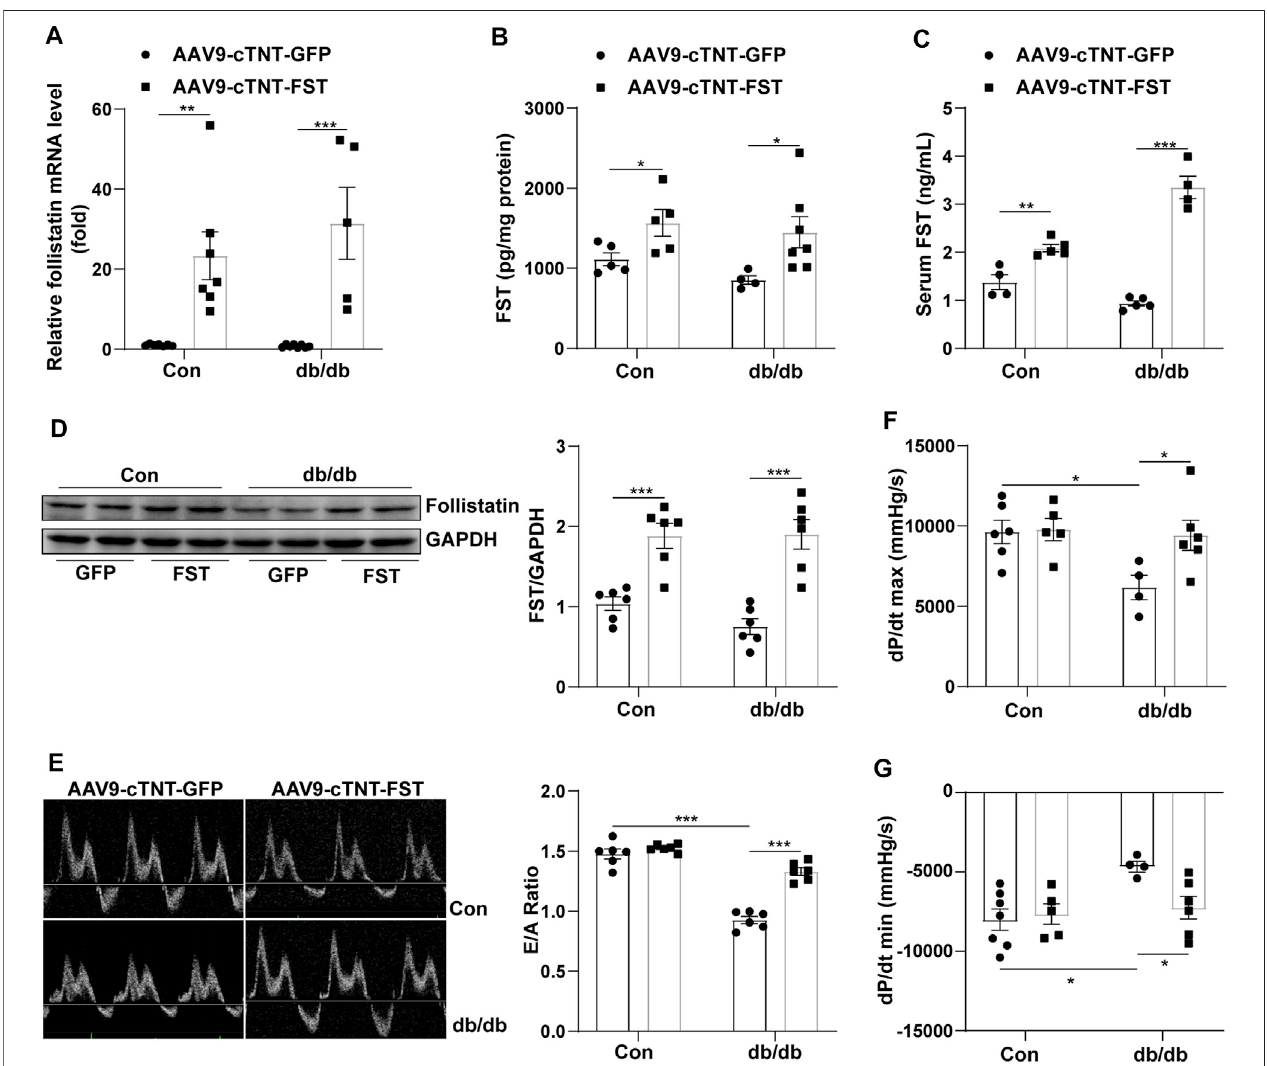
FIGURE 2 | Overexpression of FST improves heart functions. Serum FST levels in controls and db/db mice [ (C) , n ≥ 4]. FST mRNA levels in mouse heart in each group [ (A) , n ≥ 5]. ELISA results of heart FST levels in each group [ (B) , n ≥ 4]. Western blot results of heart FST levels in each group [ (D) , n (cid:1) 6]. The ratio of E/A and echocardiograph images in each group [ (E) , n (cid:1) 6]. Hemodynamic analysis of db/db mice and controls [ (F,G) , n ≥ 4]. * p < 0.05; ** p < 0.01; *** p < 0.001.